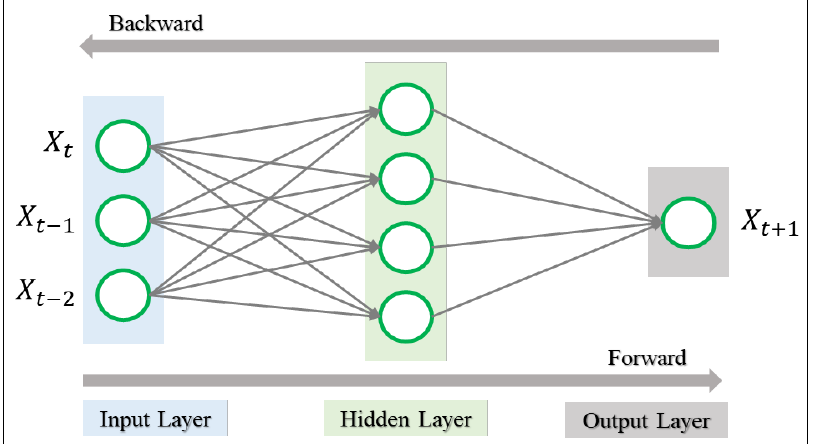
Figure 2. Multilayer Feed-Forward Neural Network with one hidden